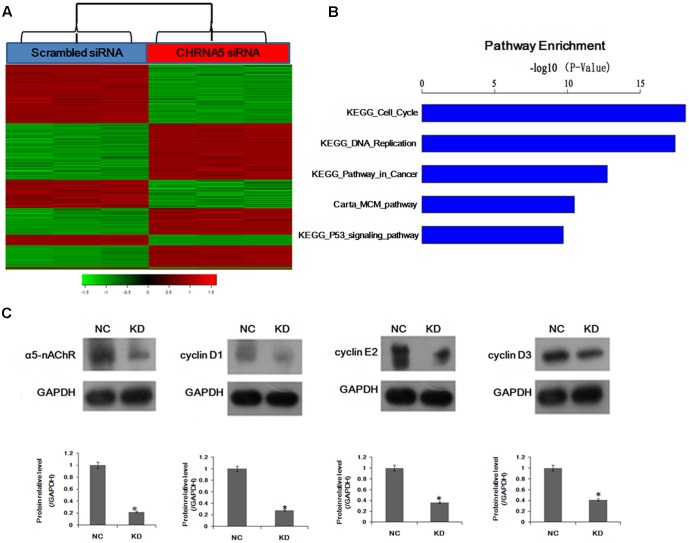
Global changes in the A549 cell transcriptome following knockdown of CHRNA5. (A) Heatmap depicting 1,972 transcripts that were significantly differentially expressed between cells transfected with scrambled (Metzger et al., 1976) and CHRNA5-specific (red) siRNA based on P < 0.01. Rows and columns represent transcripts and samples, respectively. Upregulated and downregulated gene expression is indicated by red and green colors, respectively. (B) Statistically significant modulation of the top five canonical pathways following CHRNA5 knockdown were KEGG_Cell_Cycle, KEGG_DNA_replication, KEGG_Pathway_in_cancer, Carta_MCM_pathway, KEGG_P53_signaling_pathway. (C) Confirmation of microarray profiling by Western blotting analysis of cyclin D1, cyclin E2 and cyclin D3 in A549 lung cancer cells transfected with control or CHRNA5-specific siRNA. Expression changes are depicted relative to cells transfected with control siRNA. ∗P < 0.05.